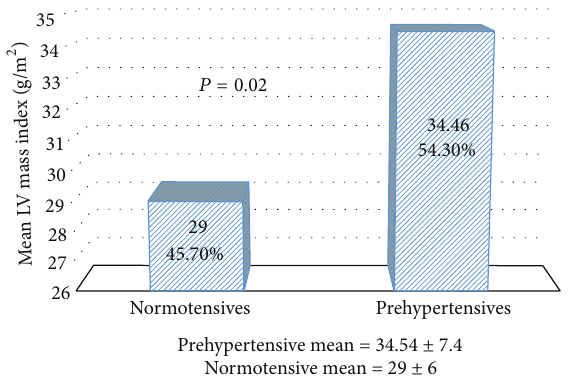
Figure 1: LV mass index in prehypertensive versus normotensive volunteers.